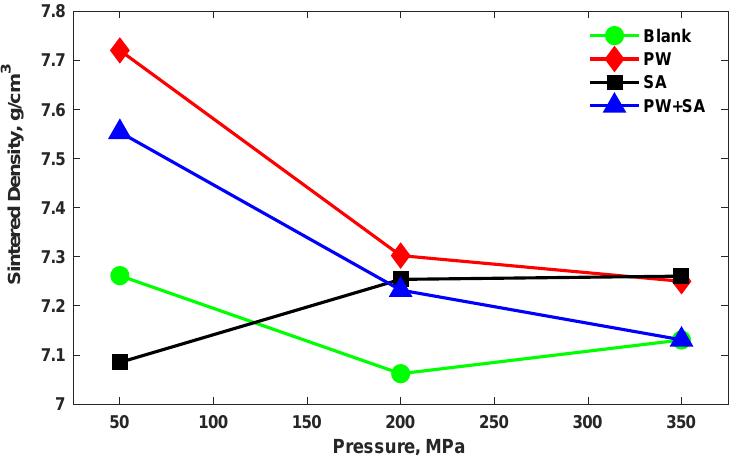
Figure 3. The effects of various compaction pressure levels on the sintered density of Cu–15Fe sintered samples, with and without different lubrication types.